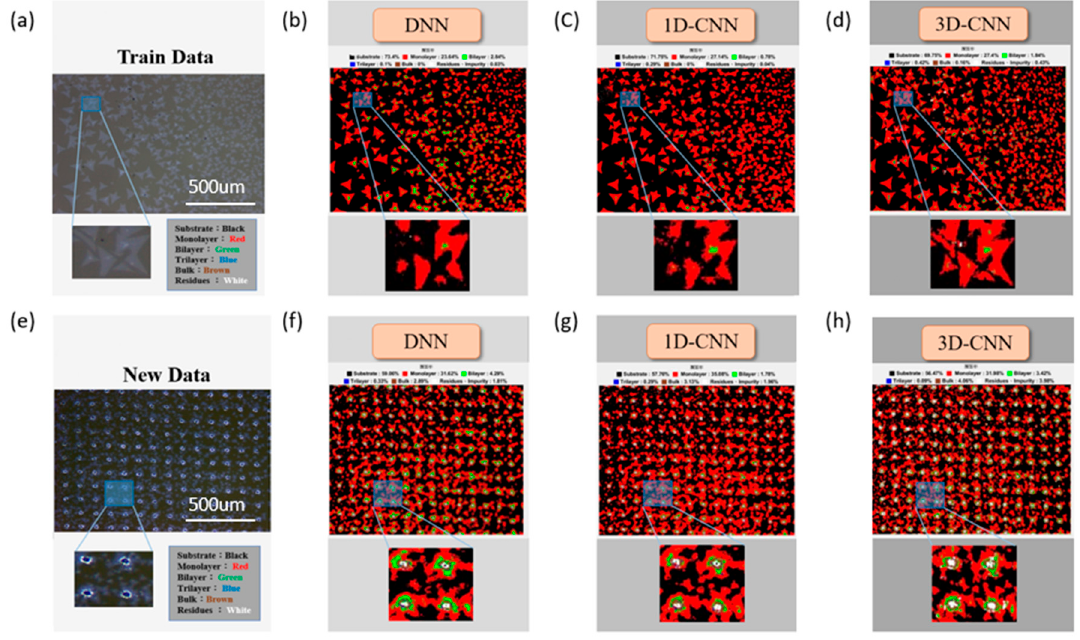
Figure 4. At 10 × magnification: ( a , e ) optical microscopy (OM) images of the training (train data) and new test (new pending data) data, respectively; predicted results of the color classification image (false-color composite) under three models for the training data ( b – d ), namely, ( b ) DNN, ( c ) 1D-CNN, and ( d ) 3D-CNN, and for the new pending data ( f – h ), namely, ( f ) DNN, ( g ) 1D-CNN, and ( h ) 3D- CNN.